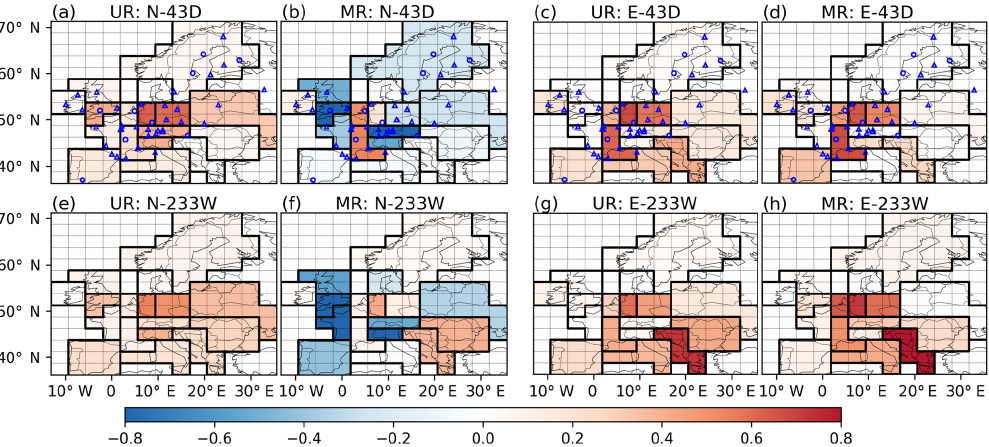
Figure 8. Average uncertainty and misfit reductions in the monthly FFCO 2 emissions over regions delineated by black lines using the NET43 network with daily sampling and NET233 network with 2-week sampling. The first and second columns are the results of INV-N inversions. The third and fourth columns are the results of INV-E inversions. The dashed lines show the grid cells of the transport model LMDZv4. The dots and triangles are the locations of the observation sites where the gradients are extracted with respect to the JFJ reference site. Dots (triangles) correspond to “urban” (or “rural”) stations defined in Sect. 2.1. The locations of the sites in the OSSEs N-233W and E-233W are not plotted to avoid blurring the